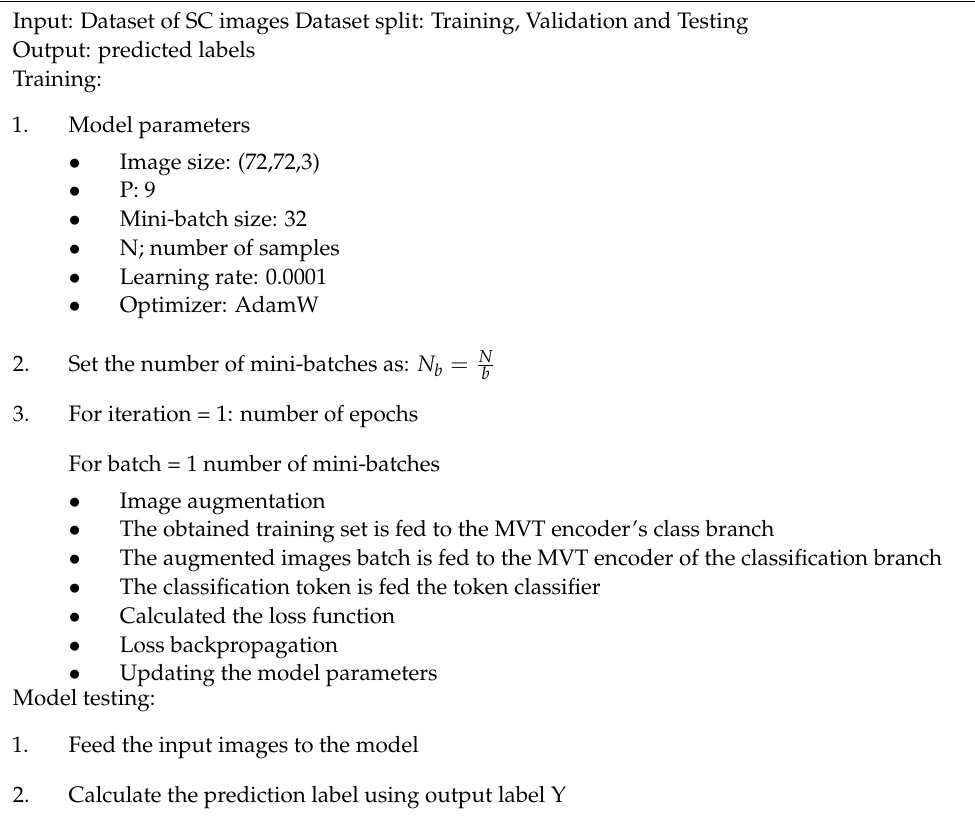
Algorithm 1 Training and testing of the proposed MVT